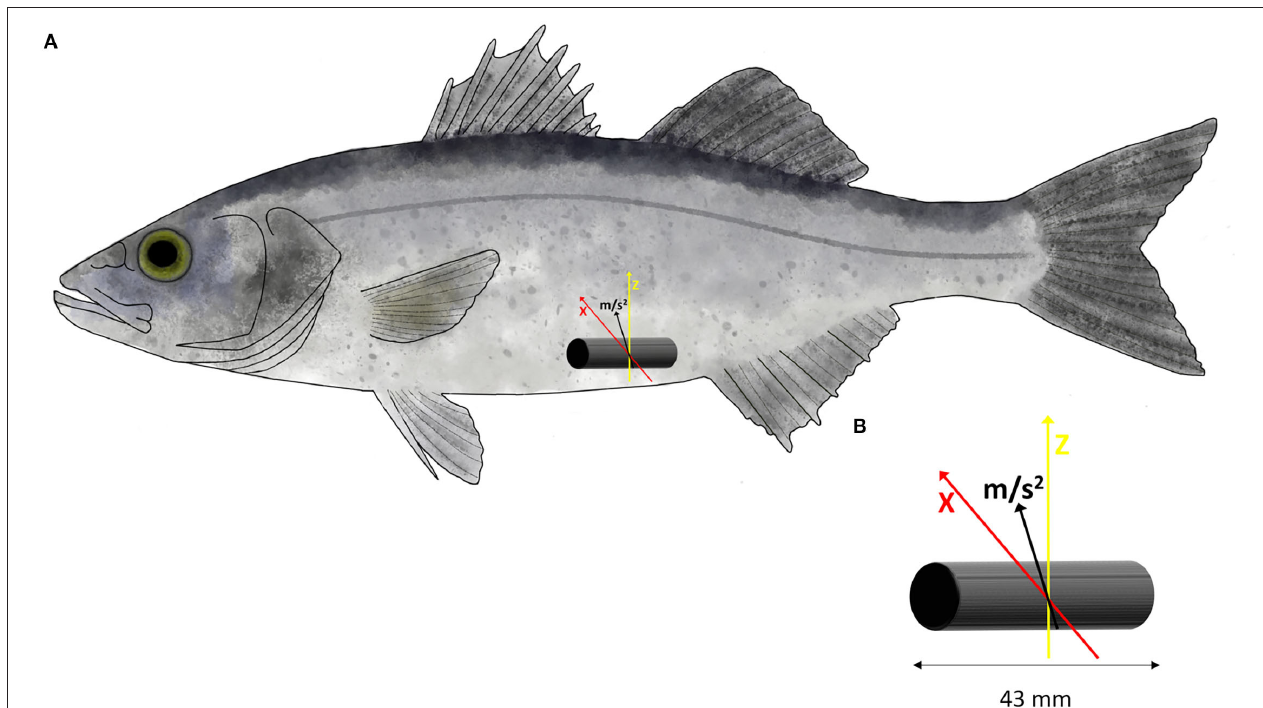
FIGURE 1 | (A) Location and position of the V9AP acoustic transmitter into the body cavity of European sea bass ( Dicentrarchus labrax ). (B) The transmitter is programmed to record the acceleration (m s 2 ) over two axes (X, in red and Z, in yellow).